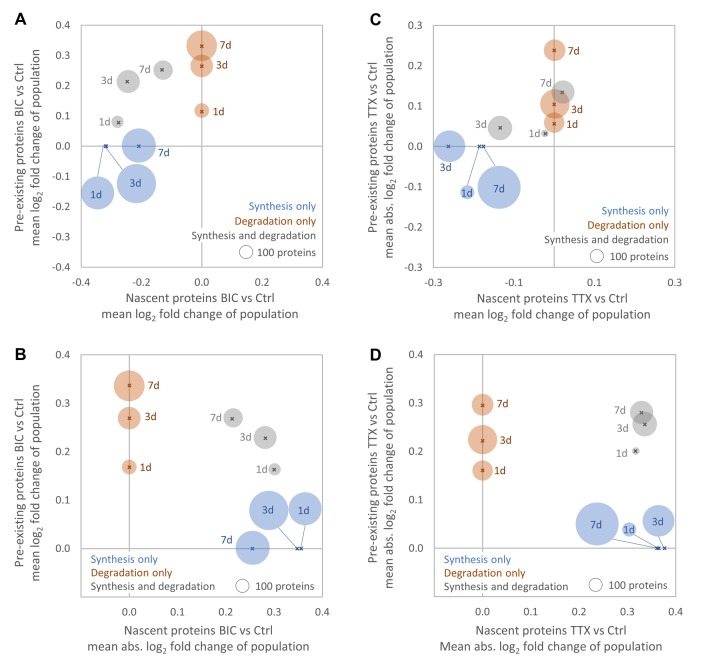
Temporal changes in protein synthesis and degradation during homeostatic scaling.Global changes in protein synthesis and/or degradation after 1, 3 and 7 days of BIC-induced down-scaling (A, B) or TTX-induced up-scaling (C, D). For each time point, the average fold-change (A, C) and the average strength of regulation (B, D) of all proteins that are significantly regulated by synthesis (blue), degradation (brown) or both (grey) are shown. The circle size is proportional to the number of regulated proteins.